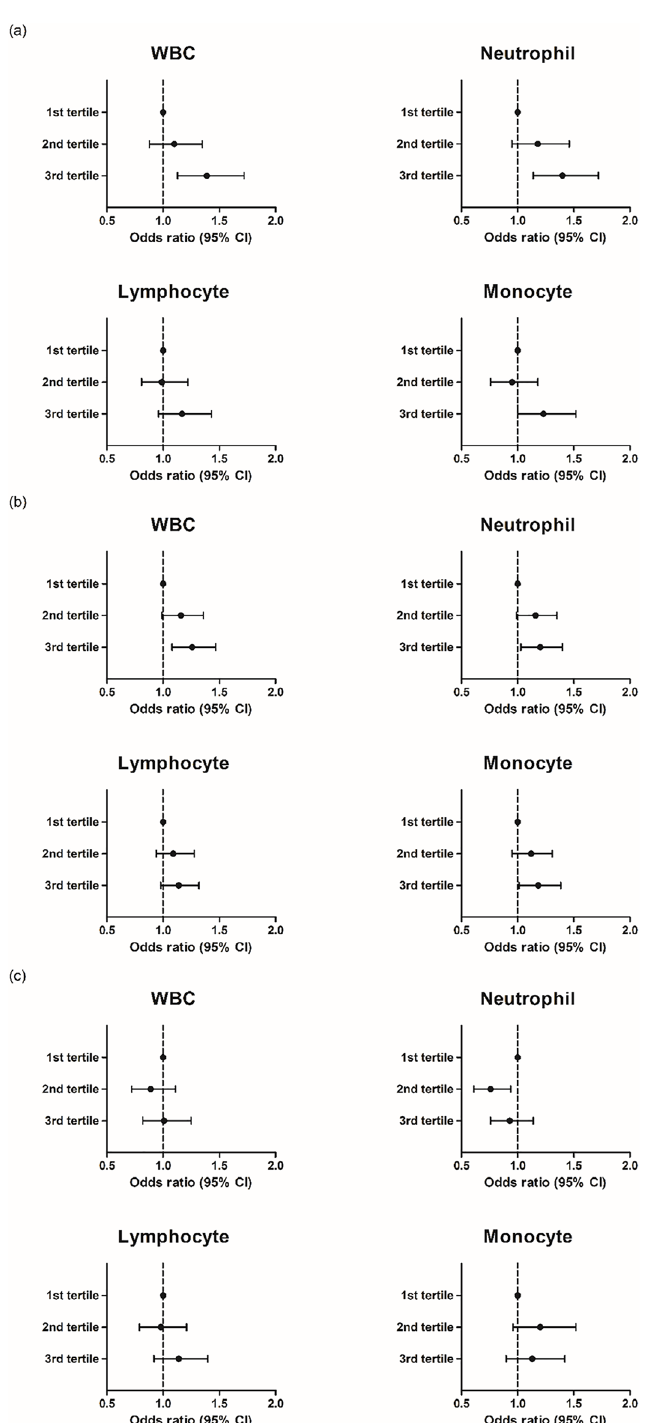
Fig 1. Logistic regression models for MDCT findings: (a) coronary arterystenosis > 50%, (b) non- calcified plaque (c) coronary arterycalcium score > 100) according to tertiles of total and differential WBC counts. (Data are shown as odds ratios (95% CI) adjusted for age, gender, BMI, smoking, diabetes, hypertension, and dyslipiemia).